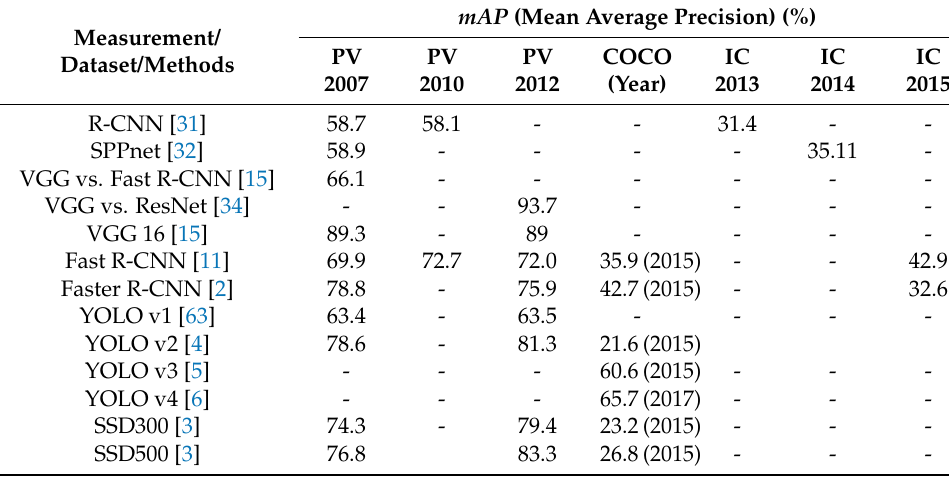
Table 1. Human detection results ( mAP ) on the several benchmark